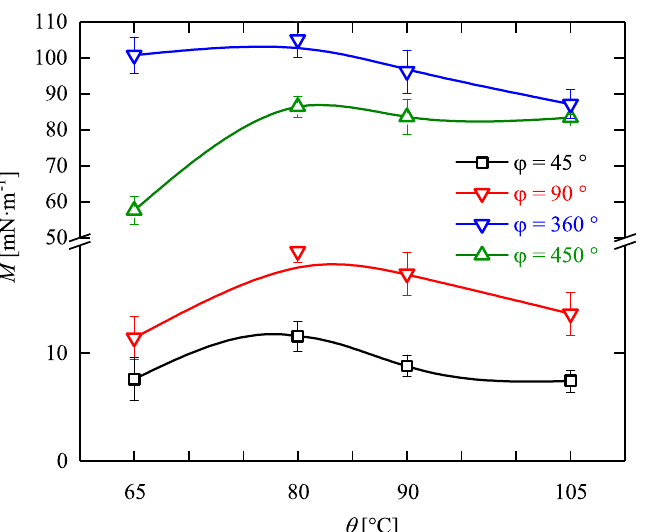
Figure 7. Evolution of maximum torque needed to deform Estane up to different twist angles at distinct programming temperatures.